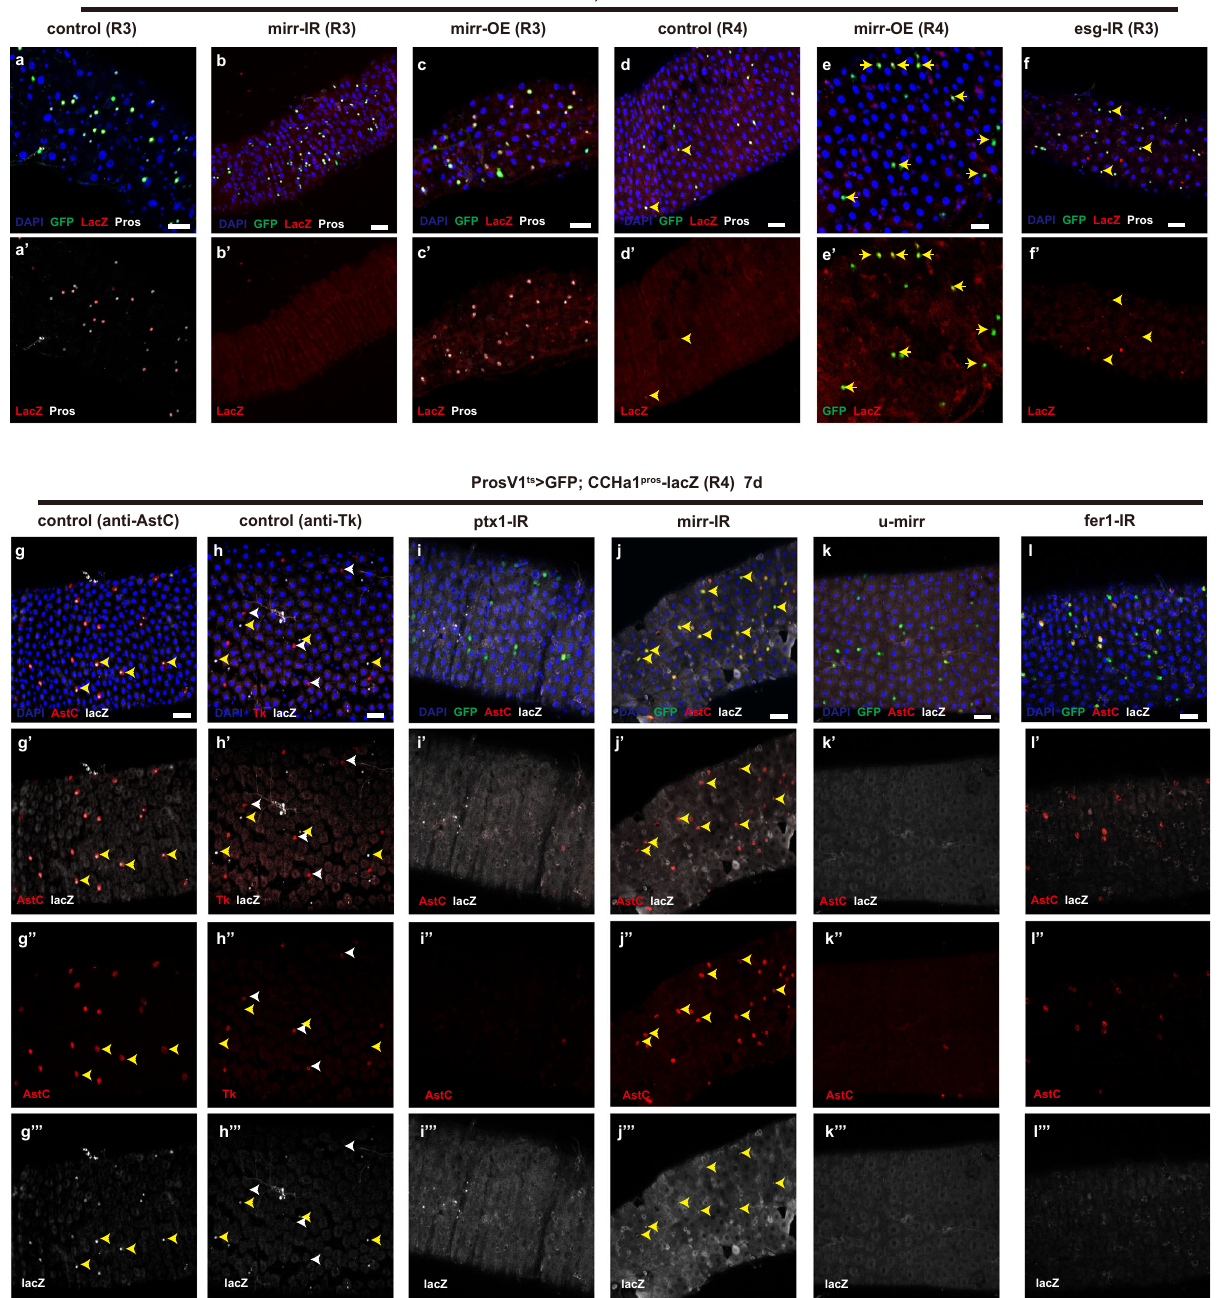
Fig. 5 | Pros and 2 0 TFs cooperate with 3 0 TFs to de fi ne subclass EE subtypes. a – f ExpressionofNPF Pros -lacZinbothR3( a )andR4( d )regionsanditsregulationby Mirr(2 0 TF)andEsg(3 0 TF),aregion-speci fi cEEfactor.Knockingdown mirr ( b )and esg ( e ) by ProsV1-Gal4 ts signi fi cantly down-regulates NPF Pros -lacZ level, while over- expressing mirr turns on NPF Pros -lacZ expression in almost all EEs ( c , e ). Knocking down esg suppresses NPF Pros -lacZ expression in R3 EEs ( f ); co-staining of CCHa1 Pros - lacZ with AstC and Tk reveals that CCHa1 Pros -lacZ expression is expressed in AstC +